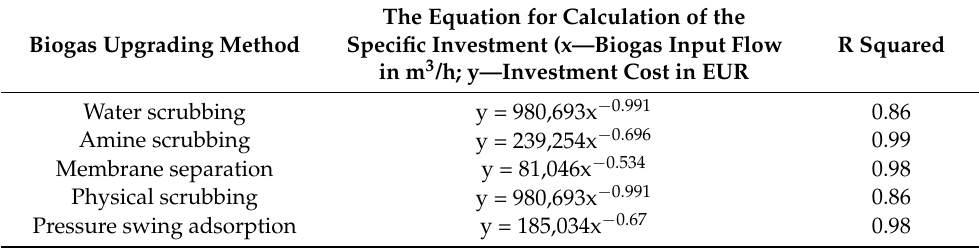
Table 7. Estimated relation between biogas input flow (m 3 /h) and specific investment costs (EUR/m 3 /h).